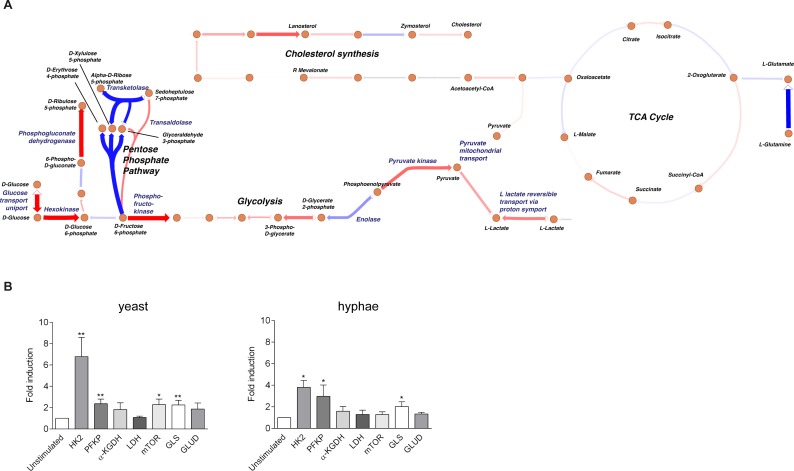
Glycolysis upregulation upon Candida stimulation.(A) Schematic pathway map of the gene expression in the main metabolic pathways in PBMCs stimulated with heat-killed C. albicans yeast 24 h after stimulation. The dots represent metabolites, and the arrows indicate reactions converting these metabolites. For each reaction it is known which enzymes (and thus which genes) are involved in catalyzing the reaction. The arrows marked in red indicate an overall upregulation of genes involved in those reactions in C. albicans versus RPMI, whereas the blue indicates a downregulation. A darker color indicates a larger change in transcript levels. The complete map stimulation as created by Escher for 4 h and 24 h stimulation is shown in S1 Fig. (B) Fold increase of mRNA expression for the indicated enzymes analyzed by RT-PCR in monocytes 24 h after stimulation with heat-killed C. albicans conidia or heat-killed C. albicans hyphae (mean ± SEM, n = 6–9; pooled from 2–3 experiments). *p<0.05, **p<0.01 Wilcoxon signed-rank test. HK2: Hexokinase 2; PFKP: Phosphofructokinase, platelet; α-KGDH: alpha-ketoglutarate dehydrogenase; LDH: Lactate dehydrogenase; mTOR: Mammalian target of rapamycin; GLS: Glutaminase; GLUD: Glutamine dehydrogenase.